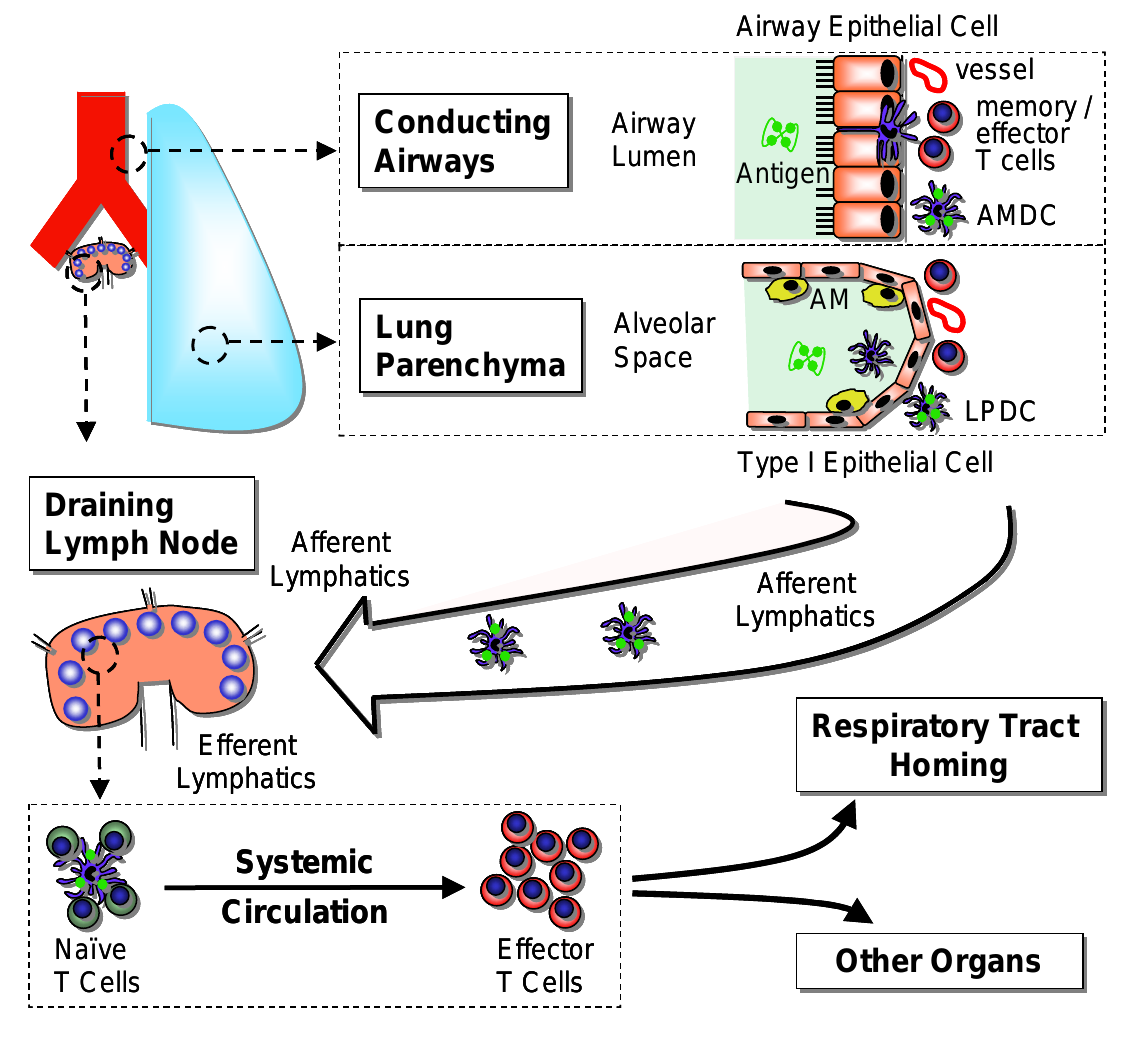
Immunological compartments in the respiratory tract. Inhaled antigen is deposited within the main conducting airways or alveolar spaces and taken up by antigen-presenting cells such as DCs or macrophages. Within the main conducting airways, airway mucosal DCs (AMDC) predominate, whereas in the lung parenchyma there is an excess of alveolar macrophages (AM) exerting an inhibitory effect on lung parenchymal DCs (LPDC) to protect vital gaseous exchange surfaces. AMDC and LPDC relentlessly scrutinise the airway lumen and alveolar space for antigen, subsequently migrating to draining lymph nodes to present antigen-derived peptides to naïve T cells, causing their differentiation into memory / effector T cells. Adapted from Holt et al.